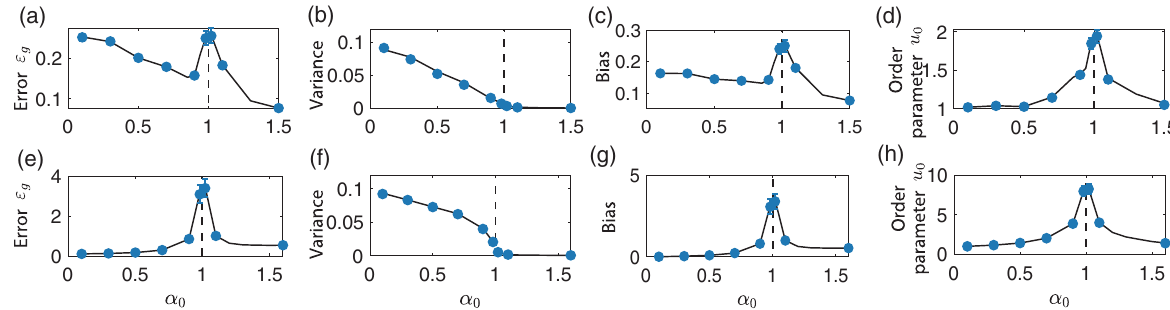
FIG. 6. Dependence of the generalization error on the training set size P for a single hidden-layer ( L ¼ 1 ) network. (a,e) Generalization error, (b,f) variance, (c,g) bias of the predictor, and (d,h) the order parameter u 0 as a function of α 0 . Note that u 0 , h f ð x Þi 2 and ε diverge as α 0 → 1 from both sides. The variance of the predictor vanishes as α 0 → 1 − and remains zero for α 0 > 1 . Black solid lines: theory. Black dashed lines: interpolation threshold at α 0 ¼ 1 . Blue dots with error bars: simulations. Error bars show the standard deviation of the mean across different realizations of the noise in the training data labels. (a) – (d) Network trained on the template model and the noisy linear teacher task with parameters described in Appendix E. (e) – (h) Network trained on the template model with random labeling of each cluster, with parameters described in Appendix E. [In this figure, we use the finite T result (Sec. IV B) for the theory curves since, as α 0 → 1 , increasingly lower T needs to be used if we want to approximate the zero T limit (see details in Appendix E and Ref. [33], Sec.